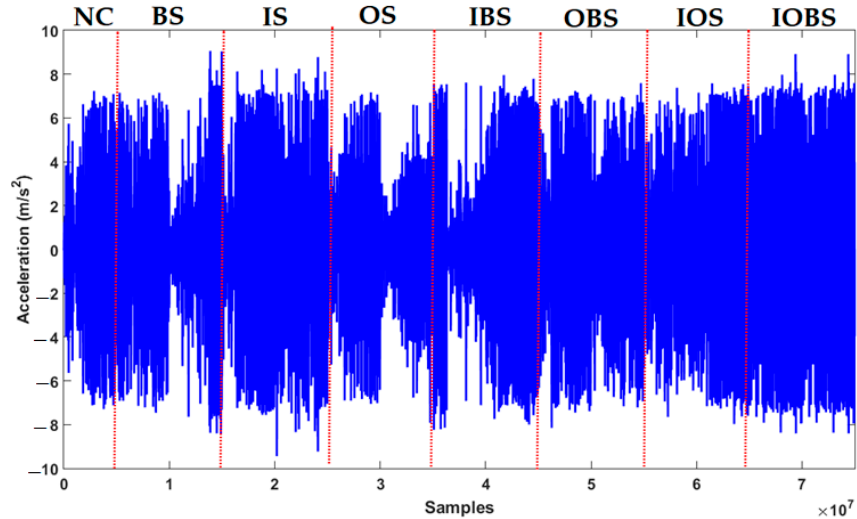
Figure 5. Original AE signals for the bearing.